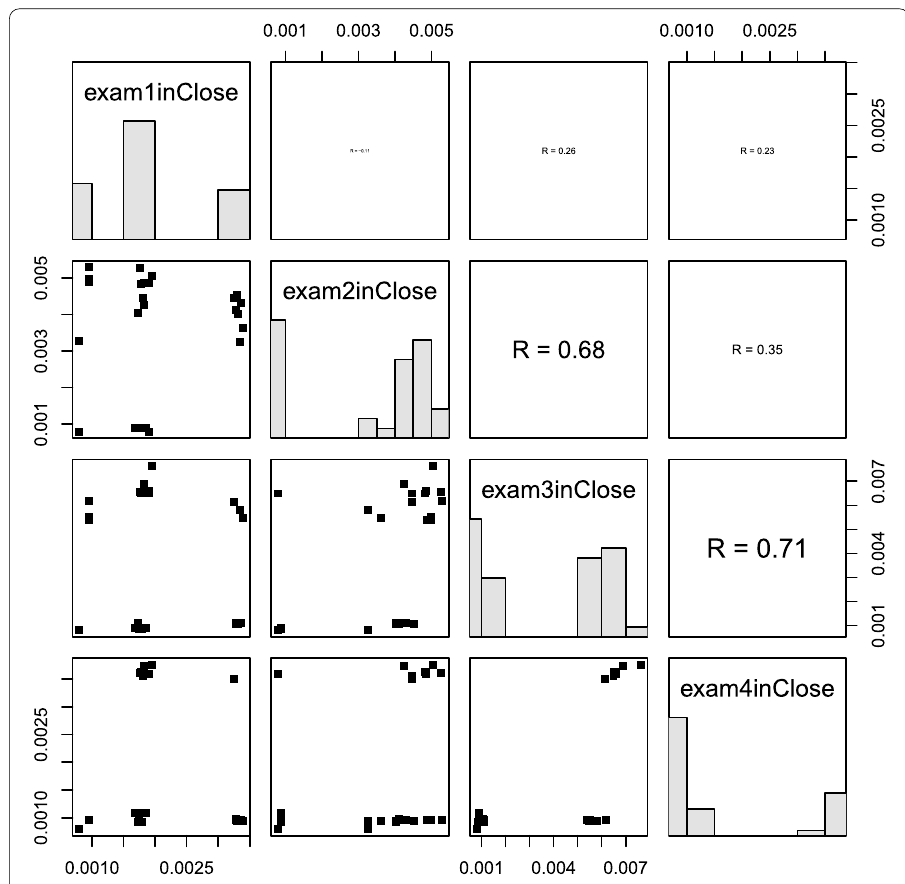
Fig. 16 In-closeness centrality distributions, scatterplots, and Spearman correlation coefficients for the Spring 2016